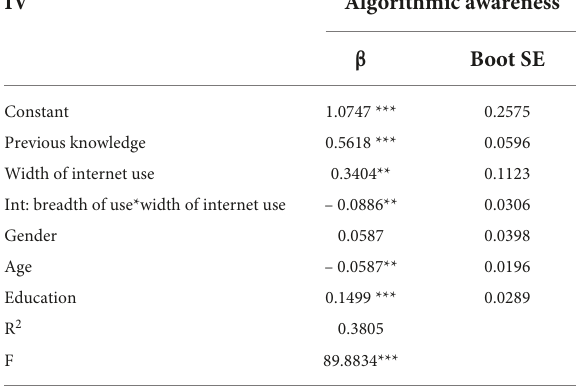
TABLE 6 The moderation effect of breadth of internet use between previous knowledge and algorithmic awareness.